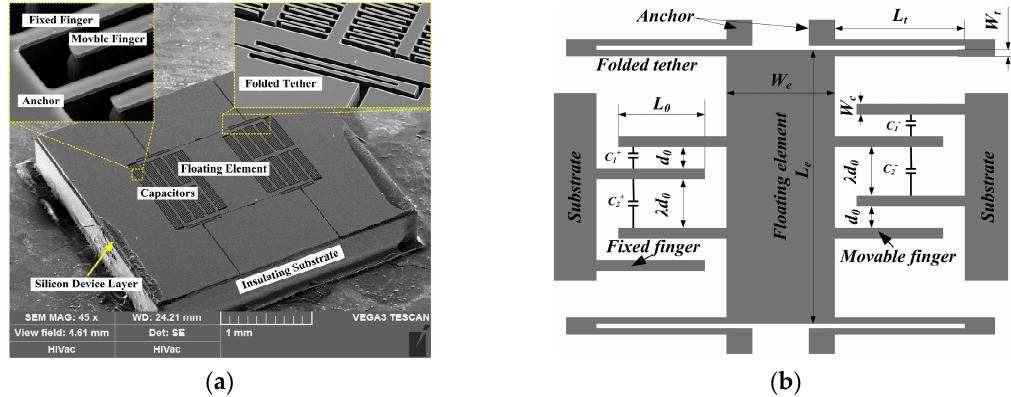
Figure 1. ( a ) shows SEM images of the floating element wall shear stress sensor with capacitive sensing, and ( b ) gives descriptions of the sensors’